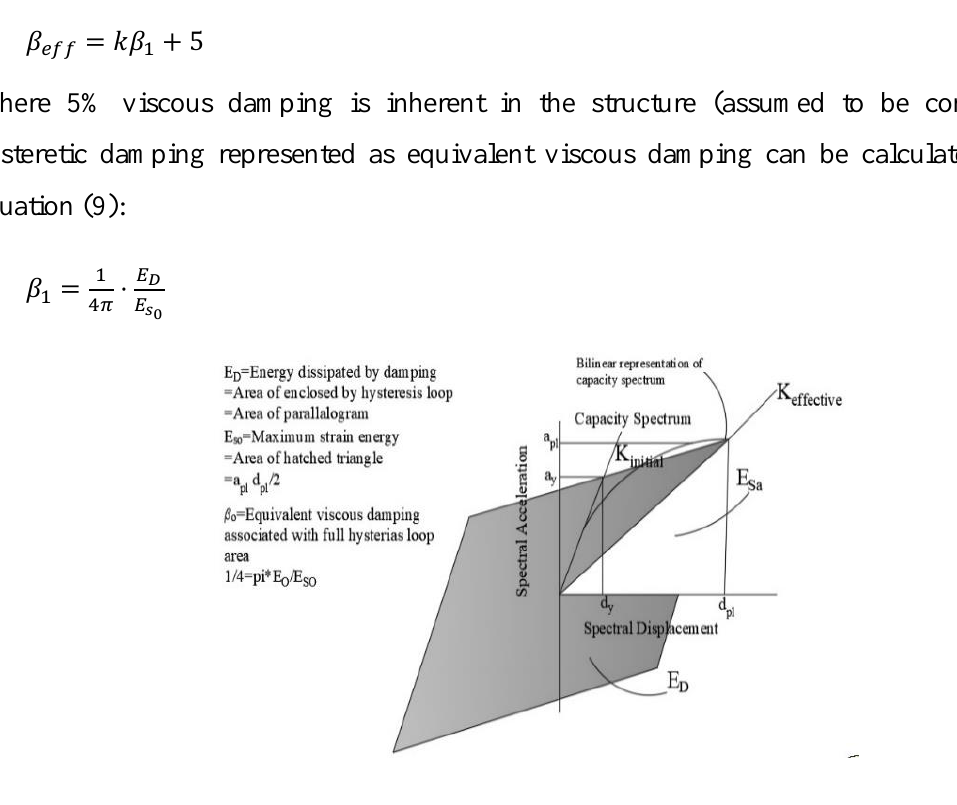
Fig. 3. Derivation of Damping for Spectral Reduction (ATC-40,